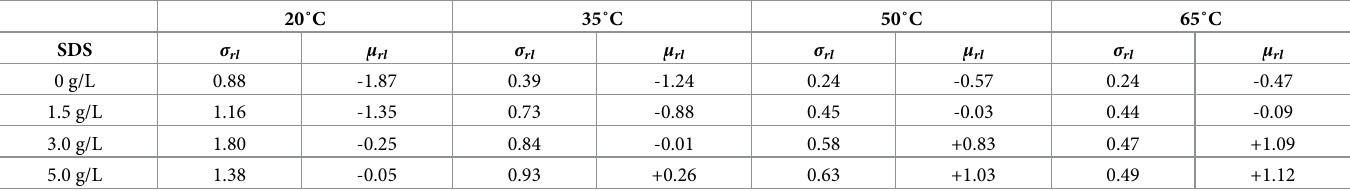
Table 2. Calculated values of σ rl and μ rl obtained from cleaning test of the hemoglobin-soiled cloth with respect to various temperature and SDS concentration levels.